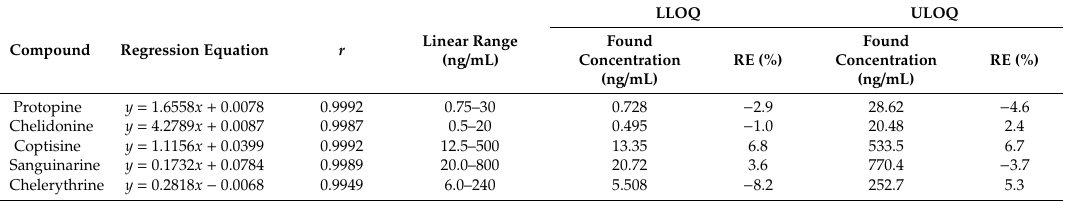
Table 1. Regression equation, linear range, lower limit of quantification (LLOQ), and upper limit of quantification (ULOQ) of five alkaloids in cell lysates by LC–MS / MS analysis. RE: relative